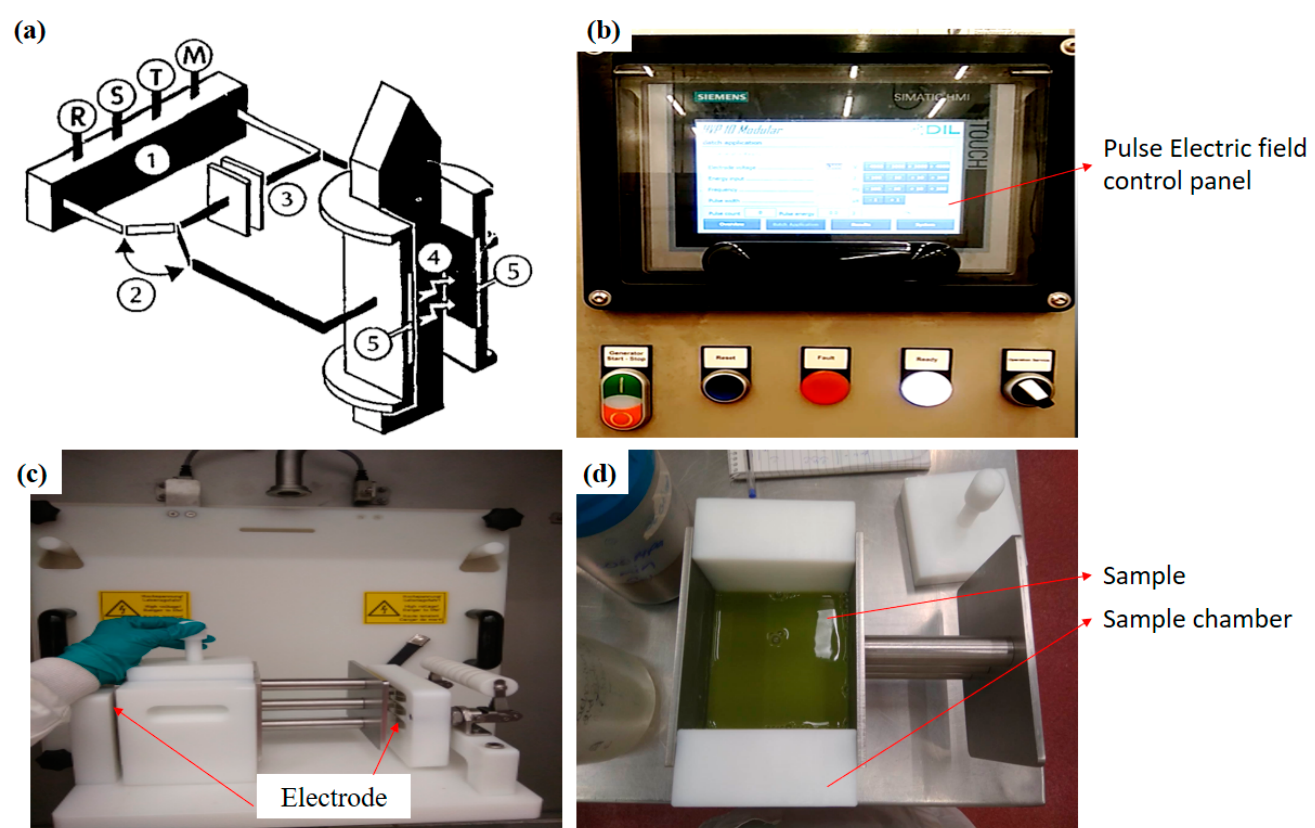
Figure 4 . Simplified schematic diagram of PEF ( a ) 1. High-voltage generator; 2. Switch; 3. Capacitor; 4. Medium; 5. Electrodes: and R, S, T, M, connector points for the main supply; ( b ) control panel of PEF; ( c ) Pulse electric field electrodes and treatment chamber; ( d ) sample chamber with sample. (Modified and adopted with permission from Knorr et al. [56] .